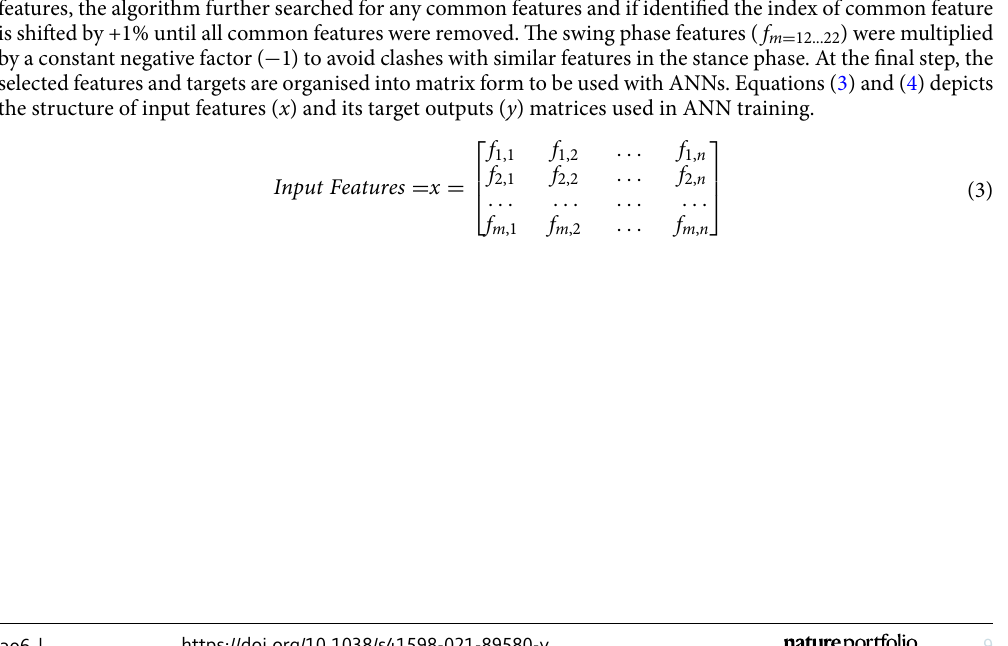
where m is the feature number and m = 2, 4, 5, 7, 8, 10, 13, 14, 16, 17, 18, 20, 21 . k is the intermediate event number within sub-phase i . Table 1 in Supplementary Information explains the heuristic of selecting indexes t . After the selection of features, the algorithm further searched for any common features and if identified the index of common feature is shifted by +1% until all common features were removed. The swing phase features ( f m = 12...22 ) were multiplied by a constant negative factor ( − 1 ) to avoid clashes with similar features in the stance phase. At the final step, the selected features and targets are organised into matrix form to be used with ANNs. Equations (3) and (4) depicts the structure of input features ( x ) and its target outputs ( y ) matrices used in ANN training.